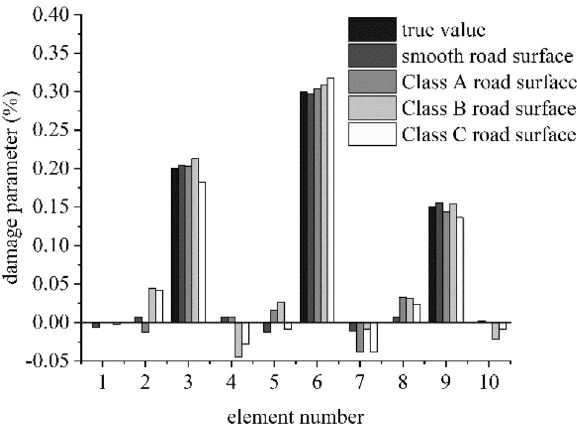
Figure 10. Damage identification results on different classes of road